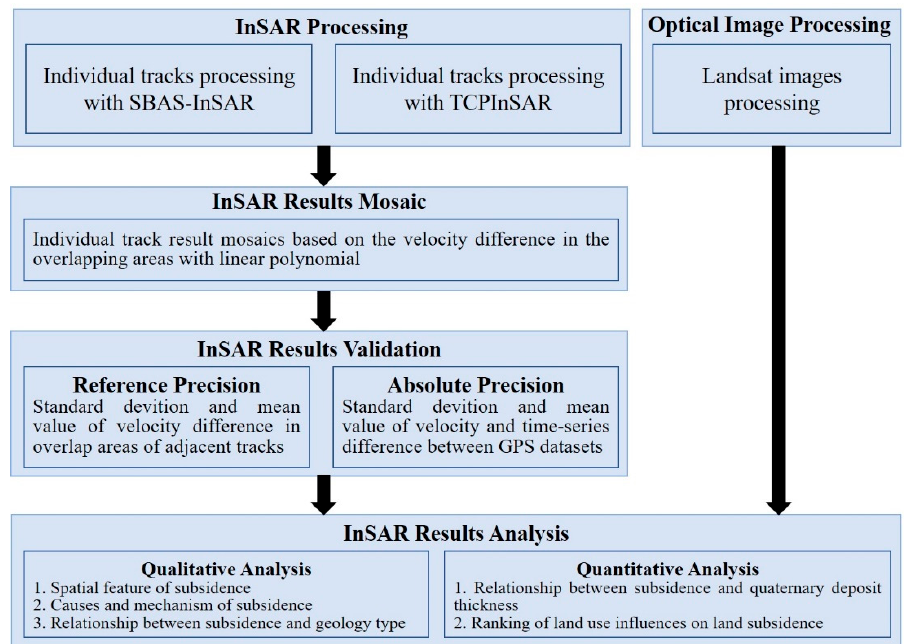
Figure 3. Flowchart of data processing.